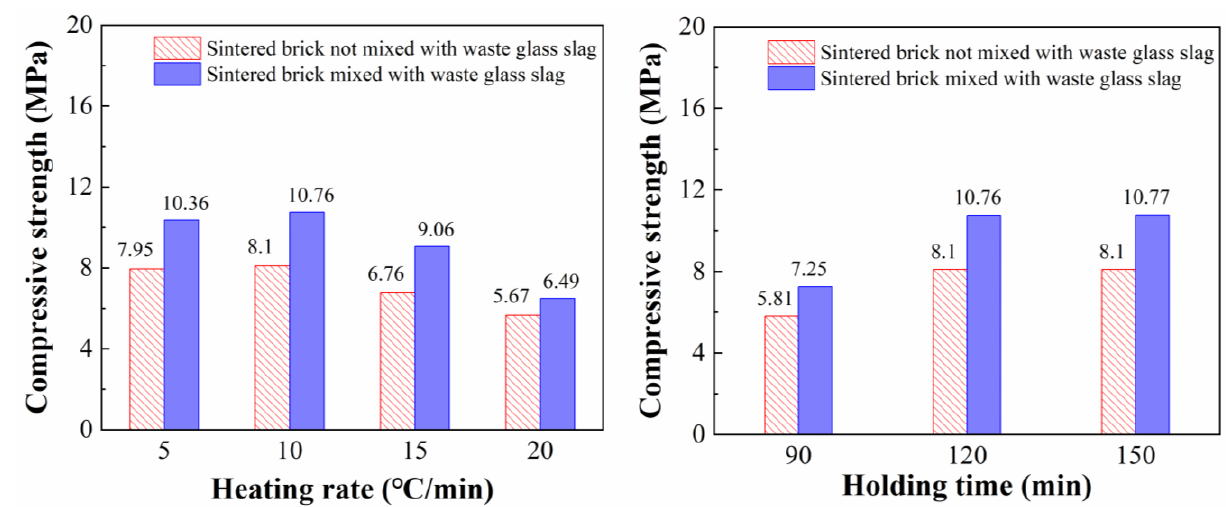
Figure 3. Effect of heating rate and holding time on compressive strength of MGB sintered brick.